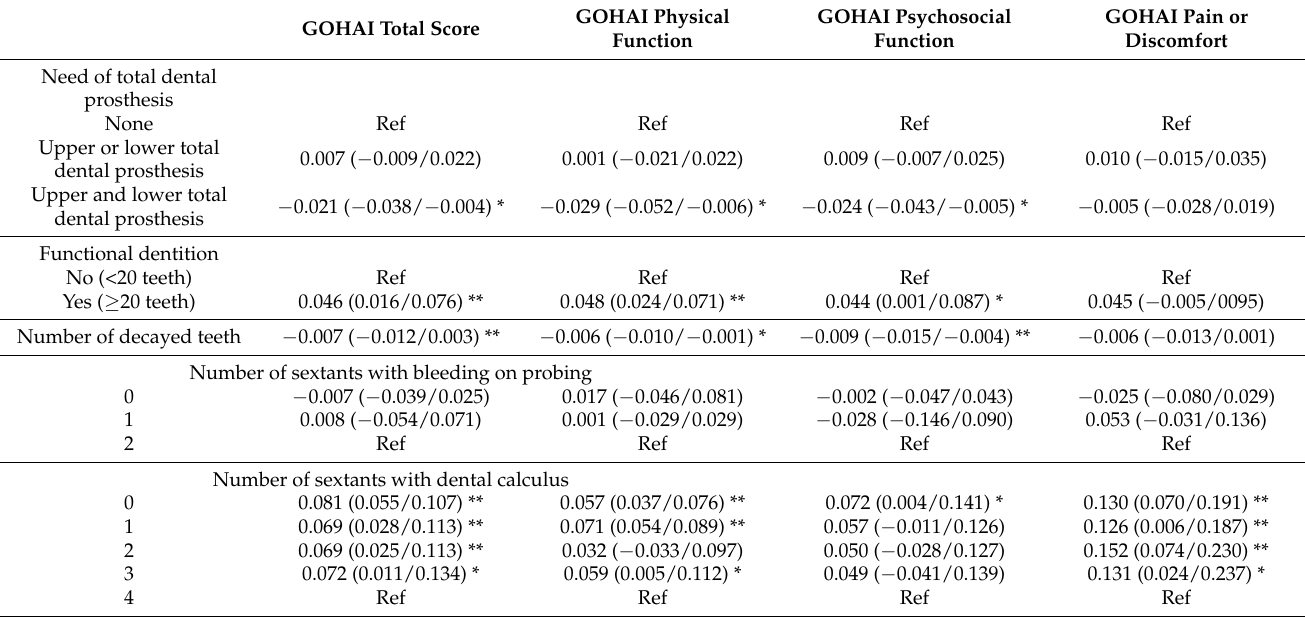
Table 5. Association of GOHAI total scores (ADD-GOHAI) and GOHAI dimension scores with need of total dental prosthesis, functional dentition (at least 20 teeth), number of decayed teeth, number of sextants with bleeding on probing and number of sextants with dental calculus. GOHAI Physical GOHAI Psychosocial GOHAI Pain or GOHAI Total Score Function Function